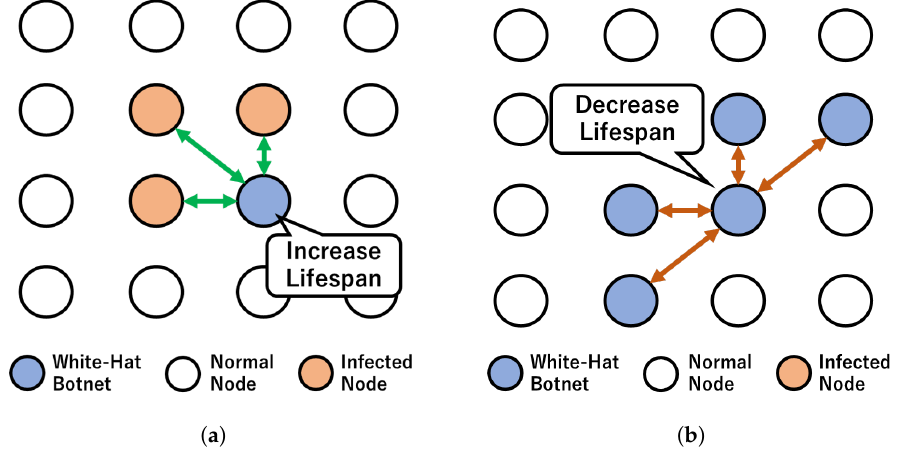
Figure 1. Overview of the dynamic lifespan control. ( a ) Increase lifespan when a white-hat botnet node encounters infected nodes. ( b ) Decrease lifespan when white-hat botnet nodes